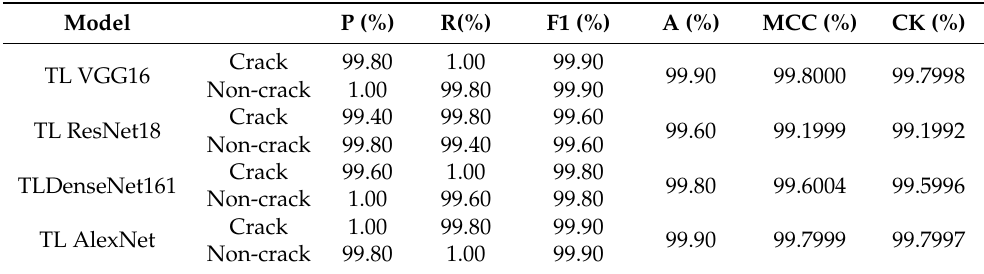
Table 7. Performance result of external dataset (BWCI) where P = Precision, R = Recall, F1 = F1-score, A =